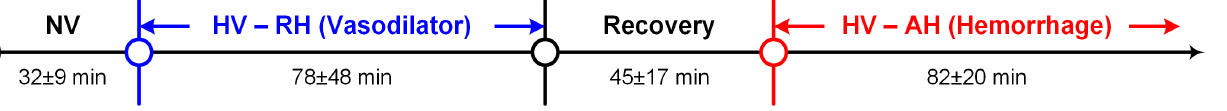
Figure 1. Experimental protocol consisting of a baseline (i.e., normovolemic (NV)) period followed by a relative hypovolemic (RH) period and an absolute hypovolemic (AH) period.